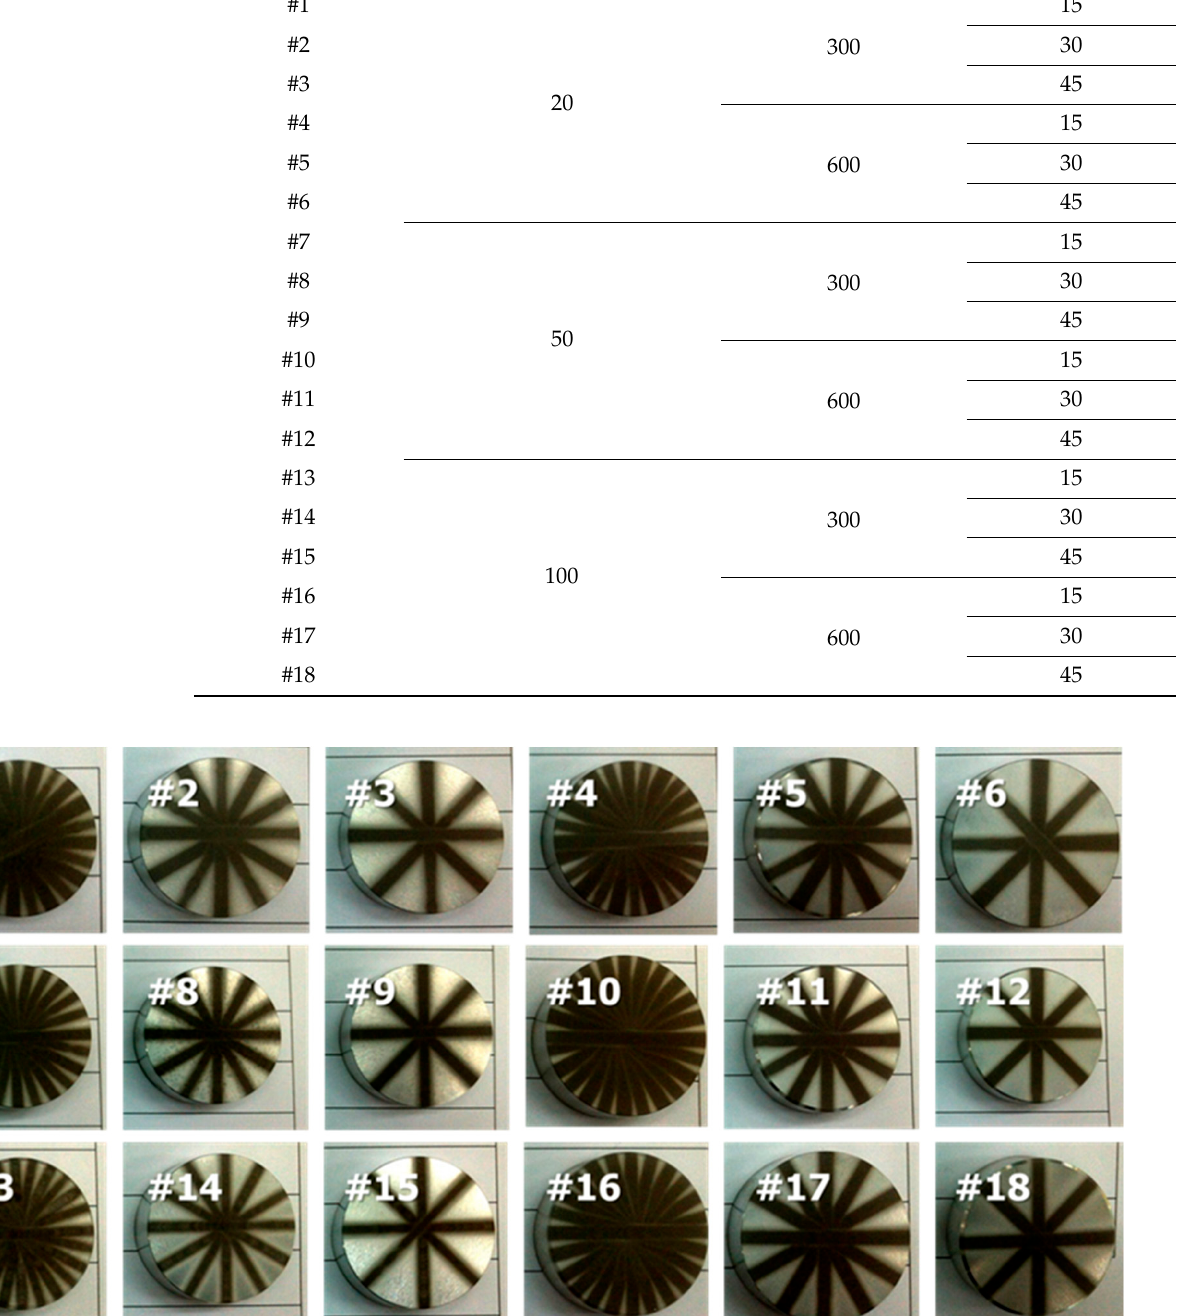
Figure 5. Optical microscopic images of the surface texture.